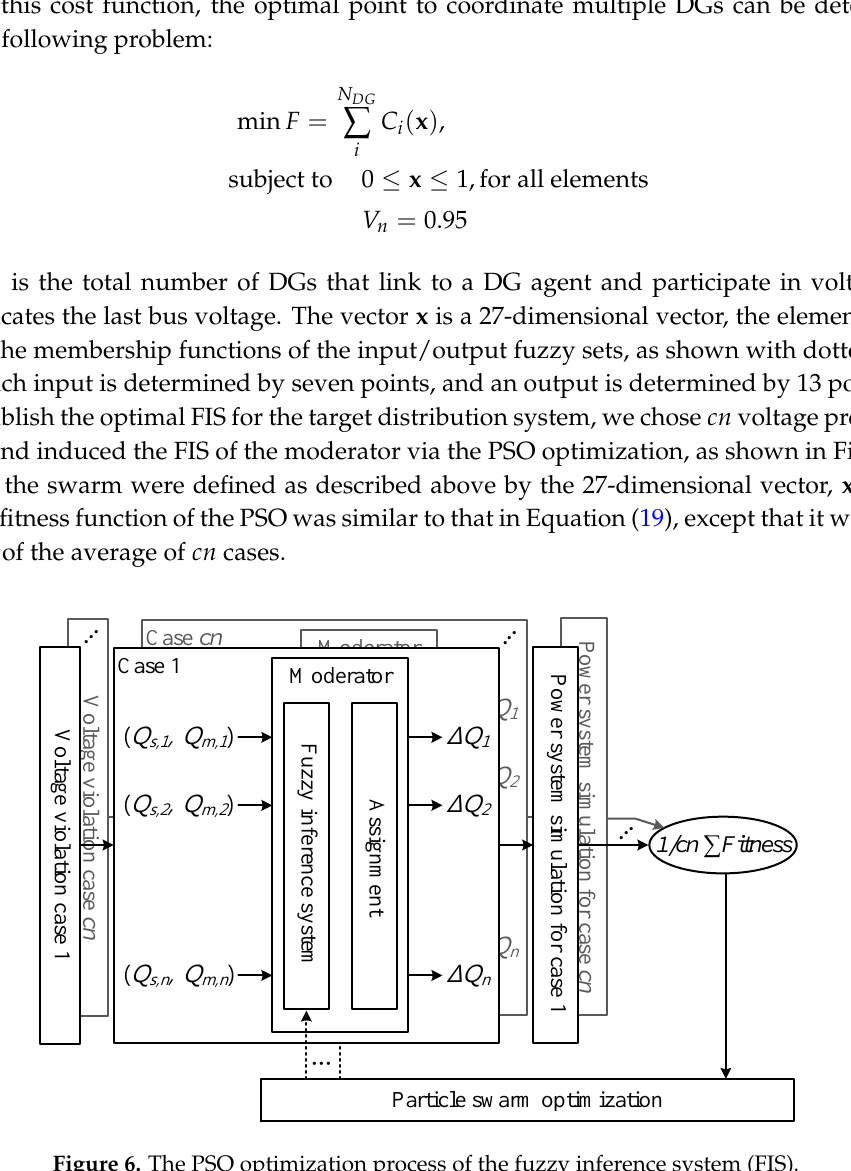
Figure 6. The PSO optimization process of the fuzzy inference system